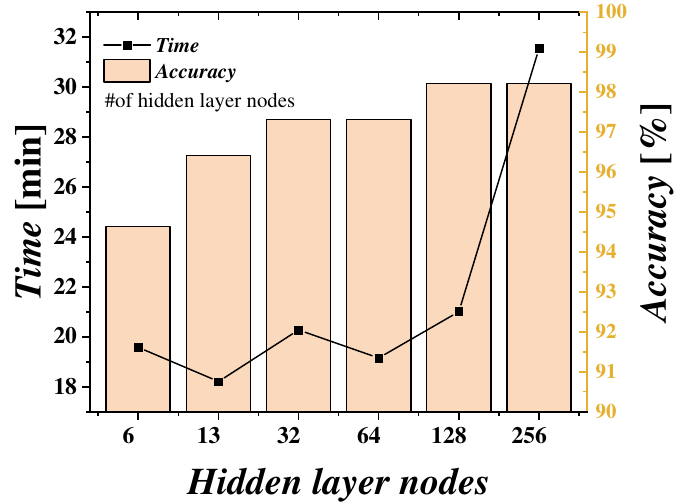
Figure 13. Highest validation data accuracy and computation time of the STM-LSTM-based fall detection system with respect to different number of hidden layer nodes.